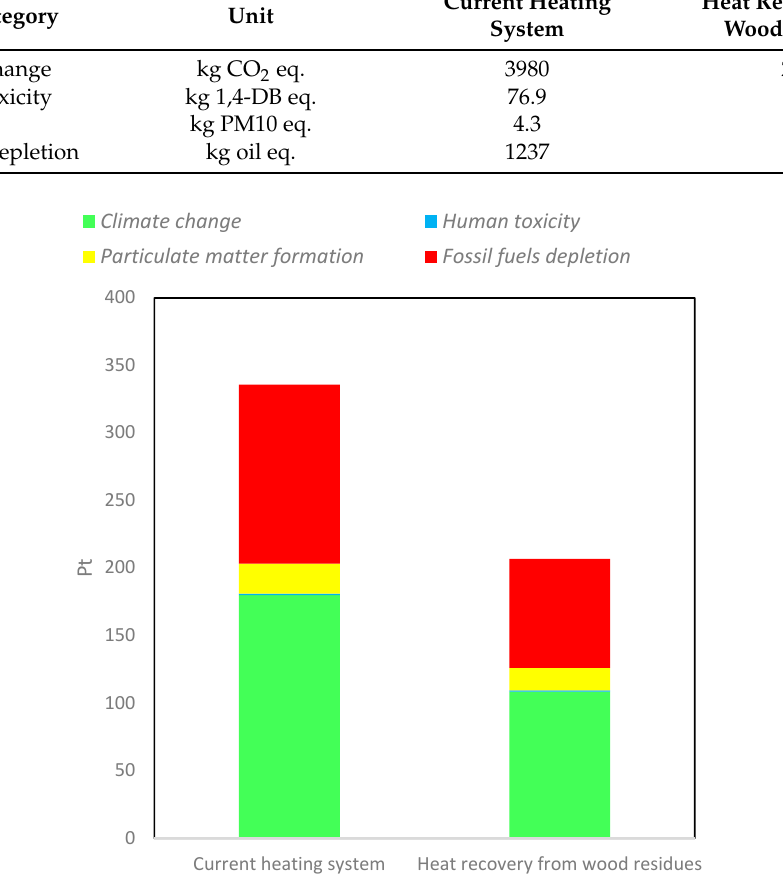
Figure 4. Single score assessment: comparison between the current heating system and the wood-based scenario for the production of 1 MWh of thermal energy.